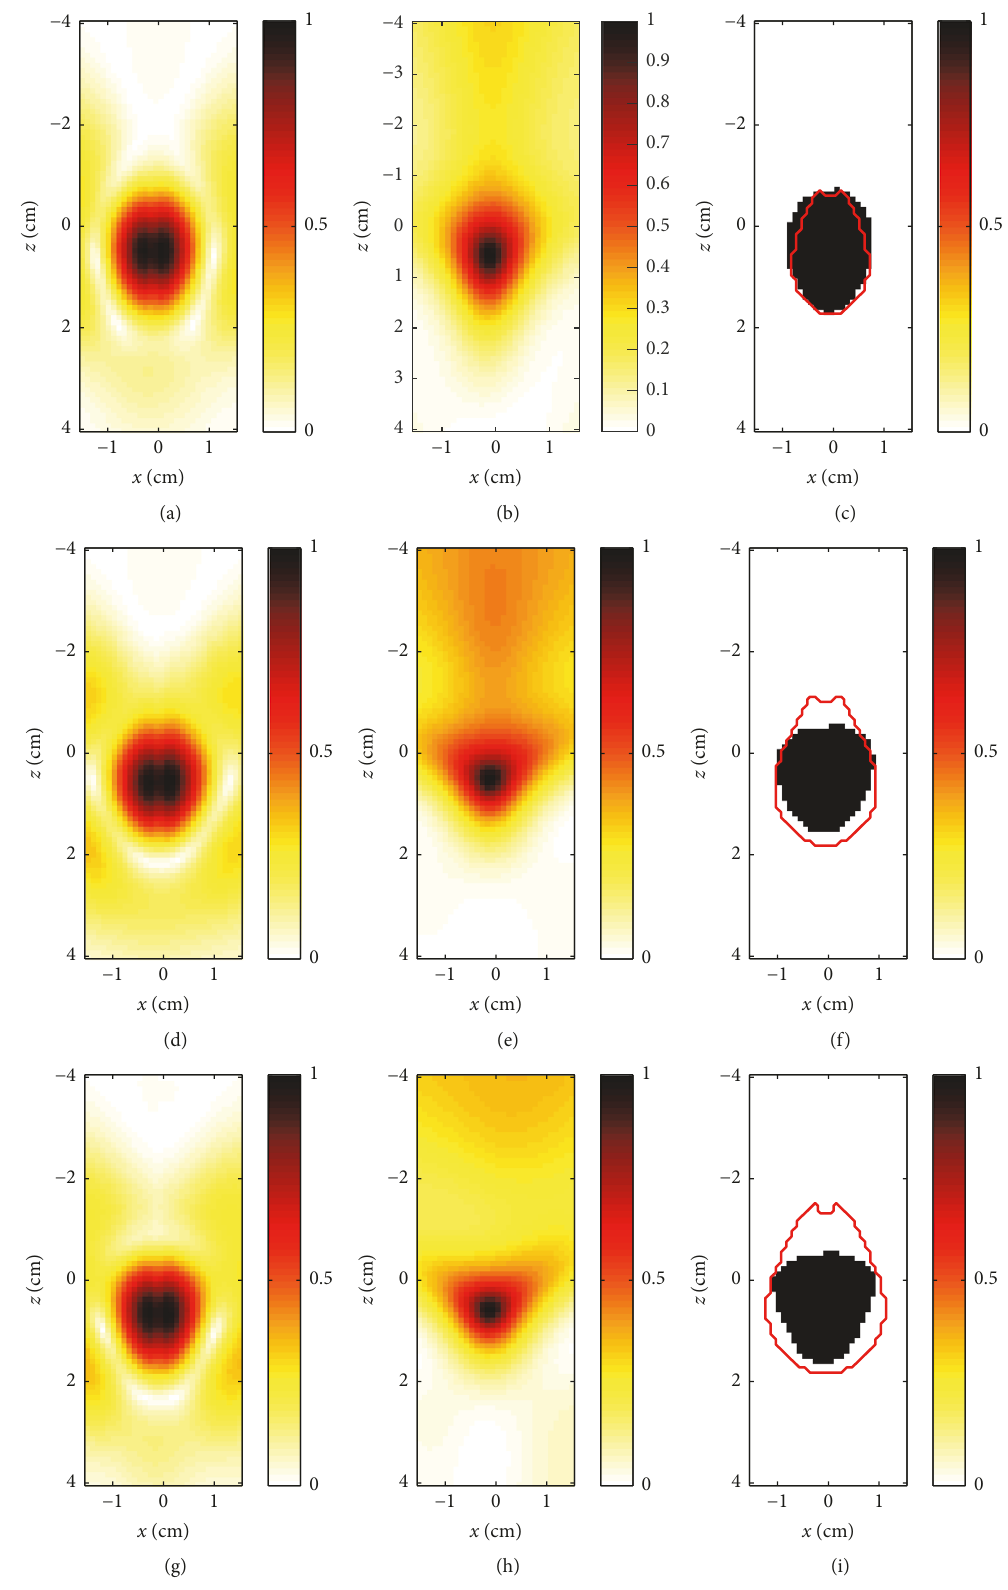
Figure 4: Reconstructions of the electric variations due to the ablation treatment for the TSVD (a, d, g) and LSM (b, e, h) algorithms and −3 dB cuts of fusion images (c, f, i), at 60 s (a, b, c), 120 s (d, e, f), and 180 s (g, h, i). The shape of the actual ablated area is superimposed (red line) to the fusion